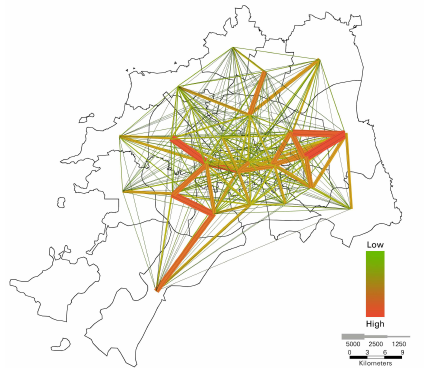
Figure 10. Desire-lines among 24 aggregated analysis zones